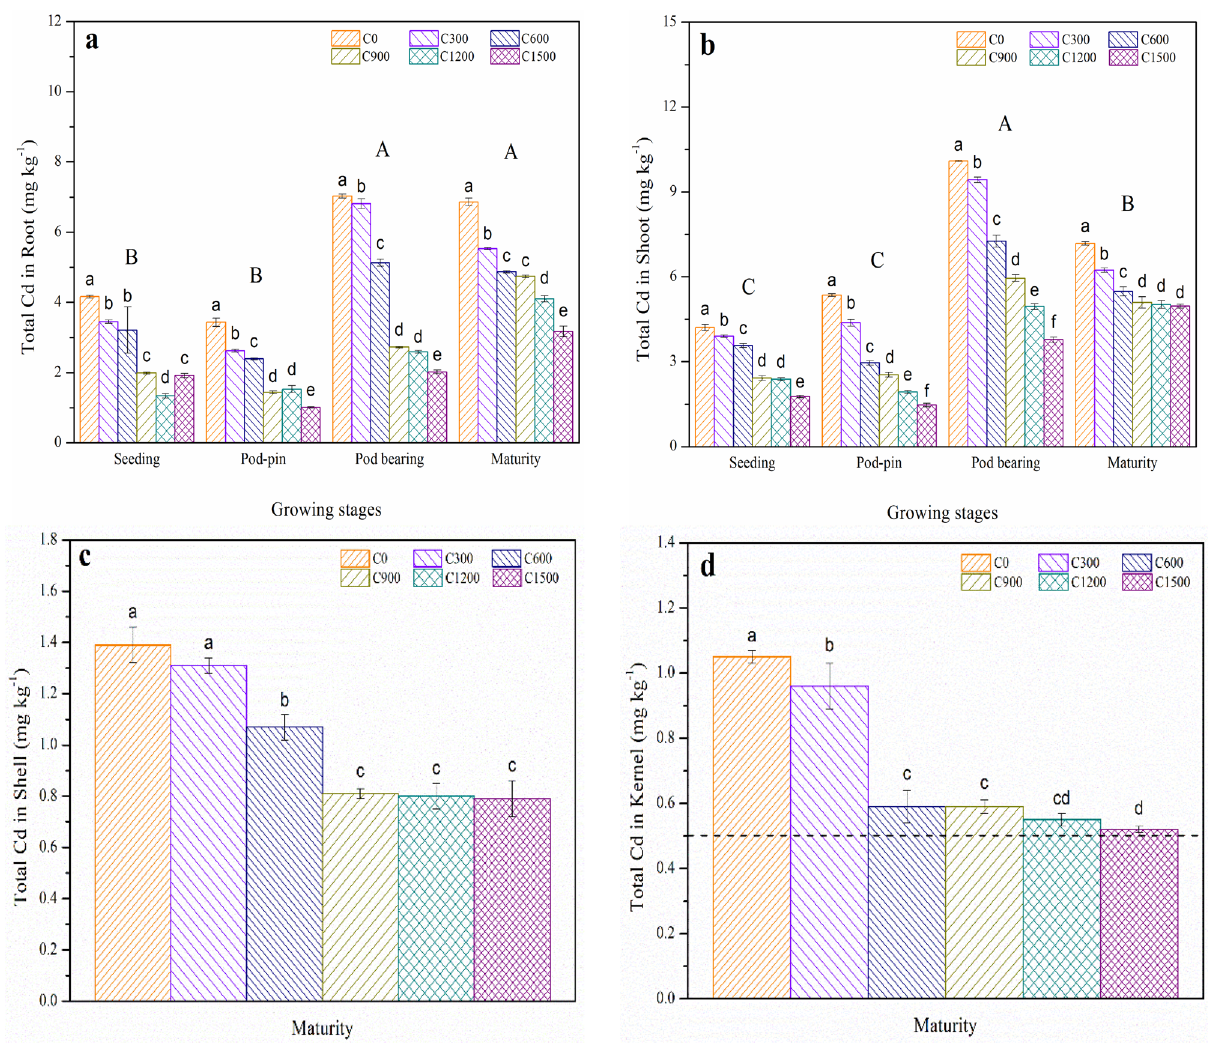
Figure 2. Effects of slaked lime application on the total Cd contents of ( a ) roots, ( b ) shoots, ( c ) shells, and ( d ) kernels for peanuts. The values are means (± SD) of three replicates. Bar groups with different capital letters indicate significant differences ( p < 0.05) among the growth stages. Bars with different lowercase letters indicate significant differences ( p < 0.05) among the six of slaked lime treatments for the same growth